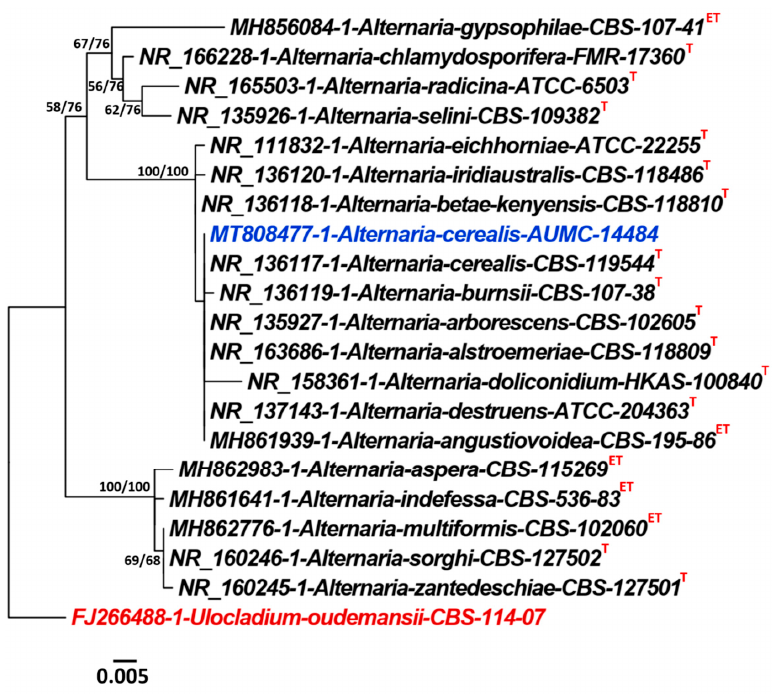
Figure 4. Phylogenetic tree generated from maximum parsimony (MP) analysis based on ITS sequence data of Alternaria cerealis AUMC 14484 (MT808477) in blue color associated with other related genes in the ITS gene sequences belonging to Alternaria . Bootstrap support values (100 replications) for ML/MP combination equal to or greater than 50% are indicated at the respective nodes. The tree is rooted to Ulocladium oudemansii CBS 114.07 as outgroup (in red color). Taxa derived from type materials are indicated with superscripts (T) and that from ex-type specimens with superscripts (ET) . The results indicated that saprophytic Trichoderma harzianum showed high antago- nistic ability against A. cerealis in PDA plates on the fifth day of incubation (Figure 5).